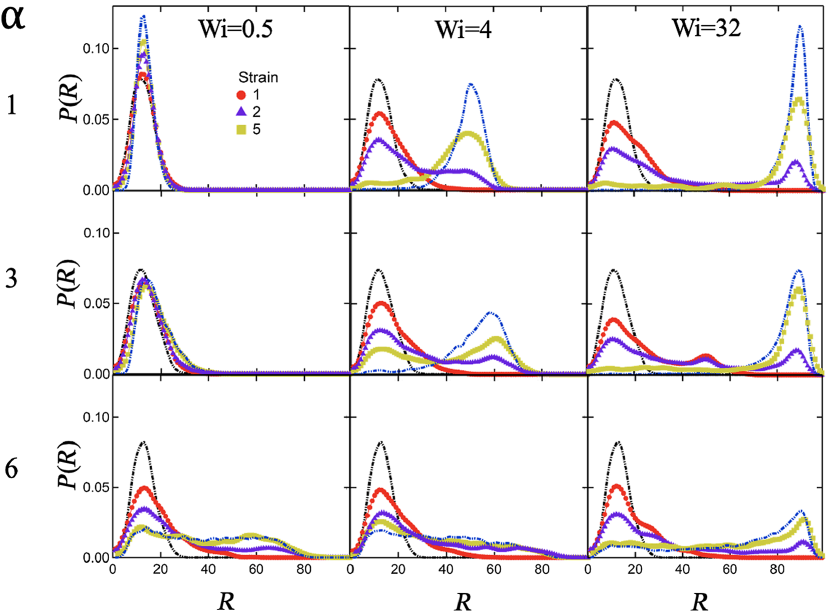
FIG. 6. Distribution function P ð R Þ of the end-to-end distance R for α ¼ 1 , 3, and 6 for Wi ¼ 0 . 5 , 4, and 32 for strain ε ¼ 1 , 2, and 5. Black and blue dot-dashed lines correspond to P ð R Þ for equilibrium and average over strain interval 5 – 10,